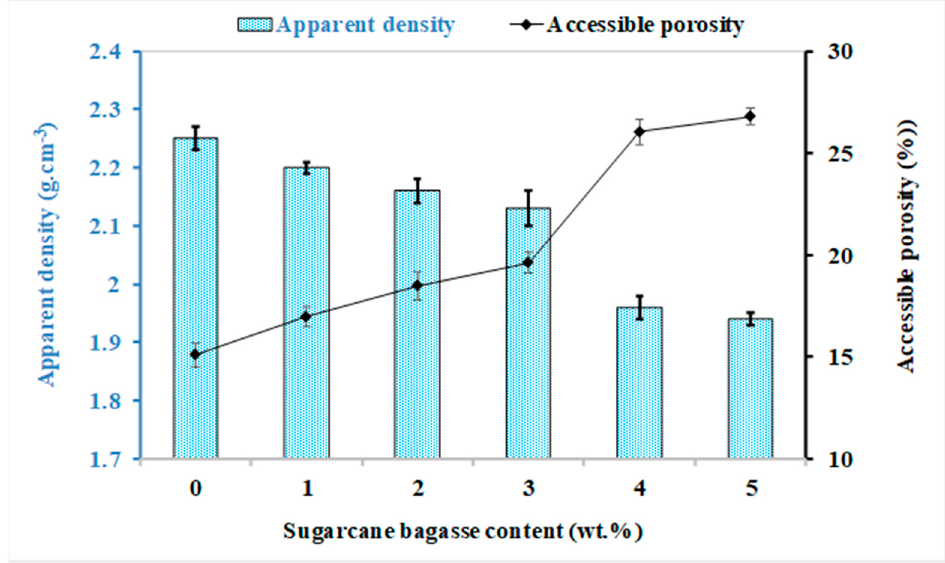
Figure 9. Apparent density and accessible porosity of adobes reinforced with sugarcane bagasse.